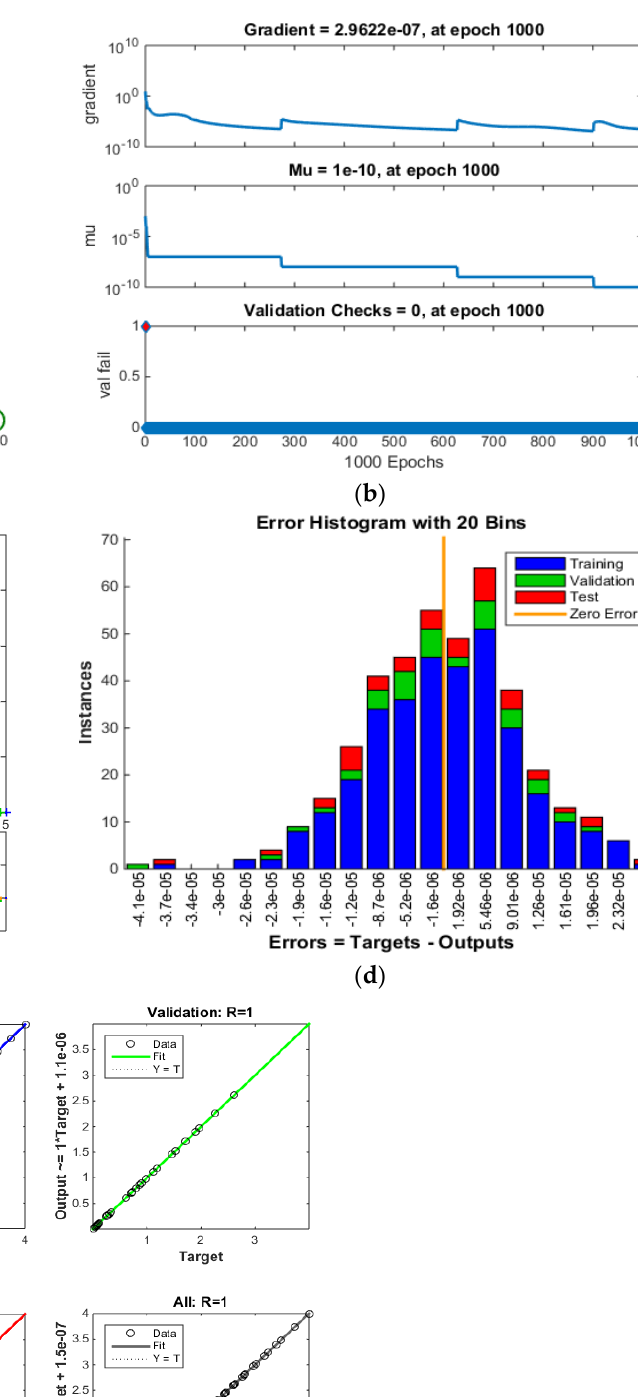
Figure 5. Graphic representation for designed LMT-ABPNN for solving cases of 𝑀 for 𝑓′(𝜂) of MHD-SGFM. ( a ) MSE Result, ( b ) Results of the transition state, ( c ) Fitness of the curve, ( d ) Histogram for error analysis, ( e ) Regres- sion.